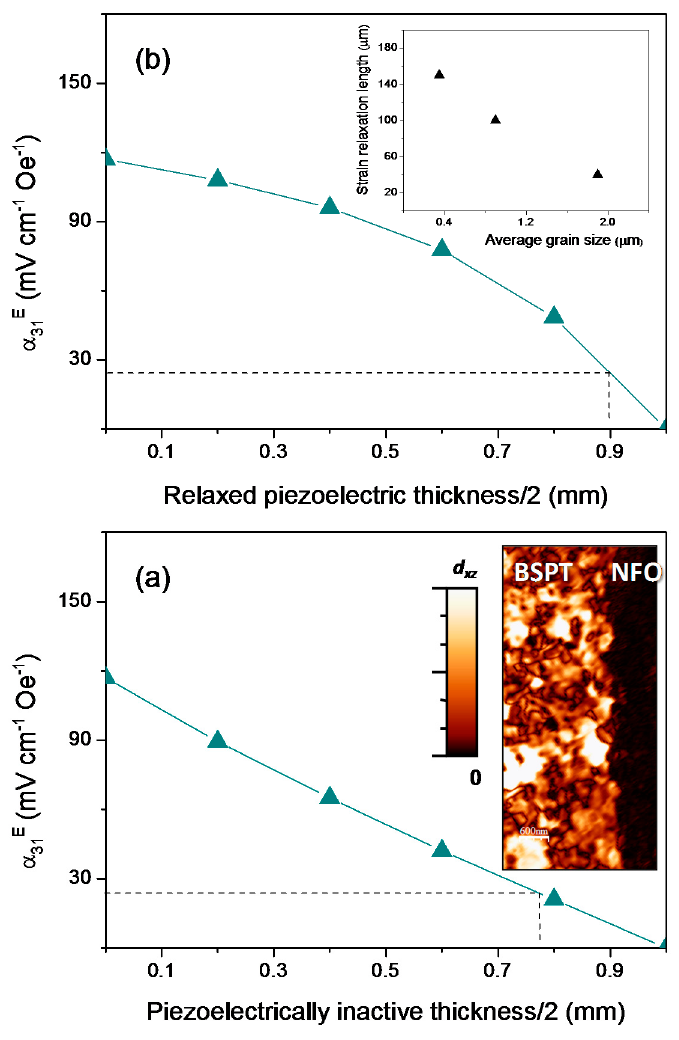
Figure 5. Comparison of experimental results for Bi 0.36 Pb 0.64 Sc 0.36 Ti 0.64 O 3 /NiFe 2 O 4 /Bi 0.36 Pb 0.64 Sc 0.36 Ti 0.64 O 3 1 mm/1 mm/1 mm three-layer composite discs with 8 mm diameter, processed by SPS at 900 °C, with results obtained by simulation of five-layer structures introducing ( a ) intermediate Bi 0.36 Pb 0.64 Sc 0.36 Ti 0.64 O 3 layers with no piezoelectricity; and ( b ) external Bi 0.36 Pb 0.64 Sc 0.36 Ti 0.64 O 3 layers with ultrahigh mechanical compliance. The inset in (a) is a PFM image of the interface demonstrating it to be piezoelectrically active, and the inset in (b) is the dependence of the strain relaxation length with grain size. Materials coefficients corresponding to processing at 900 °C have been used.